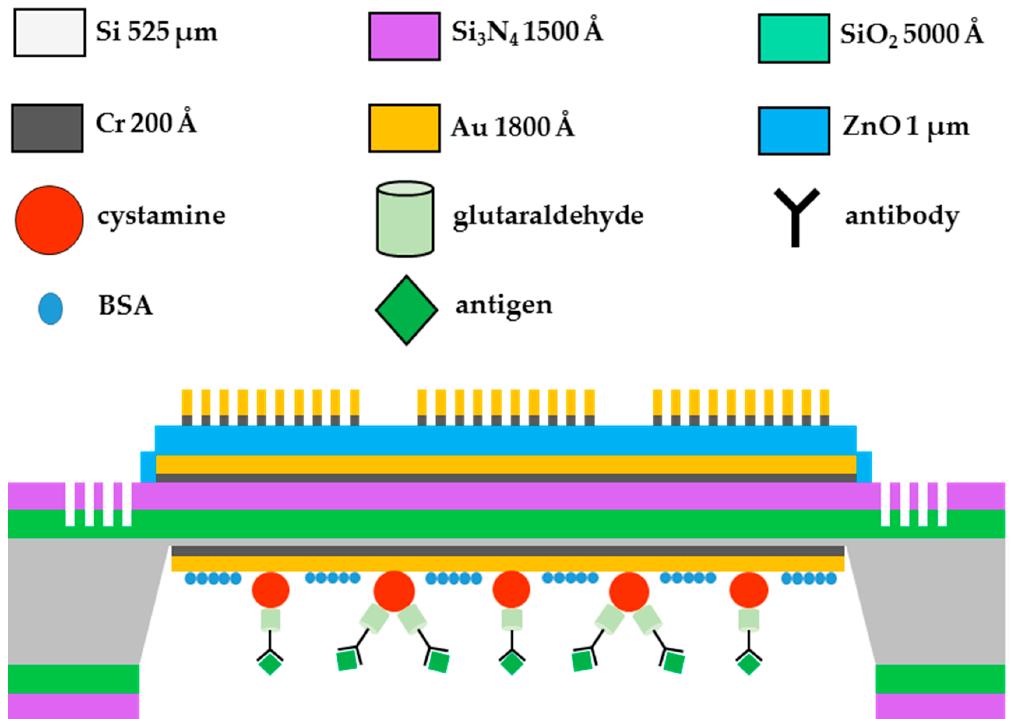
Figure 4. Final configuration of the proposed FPW-based CEA biosensor.